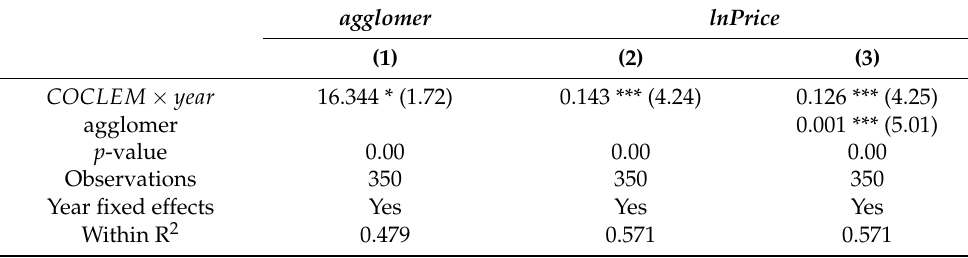
Table 6. Estimation effects of industrial agglomeration’s mediation effect on SIL transaction price.